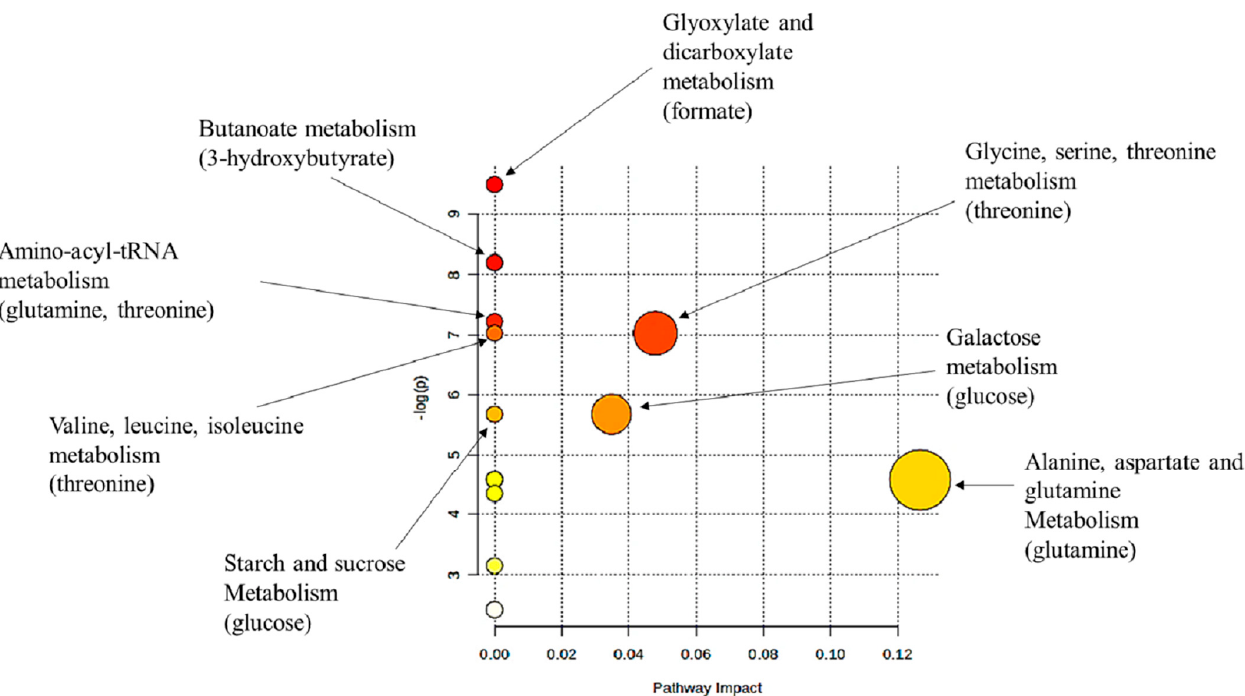
Figure 5. Pathway analysis plot based on serum metabolite profiles of analyses of lesser scaup ( Aythya affinis ), using the chicken ( Gallus gallus ) pathway library, showing significantly impacted pathways based on significant VIP metabolites that compare treatment (CORT-implanted) vs. control (placebo-implanted) groups. Only pathways that have impact scores > 0 from pathway topology analysis or significant Holm–Bonferroni adjusted p -values from pathway enrichment analysis are labelled. The diameter of each node corresponds to the impact score, and their colour gradient is related to the p -values (red = highly significant, white = non-significant).